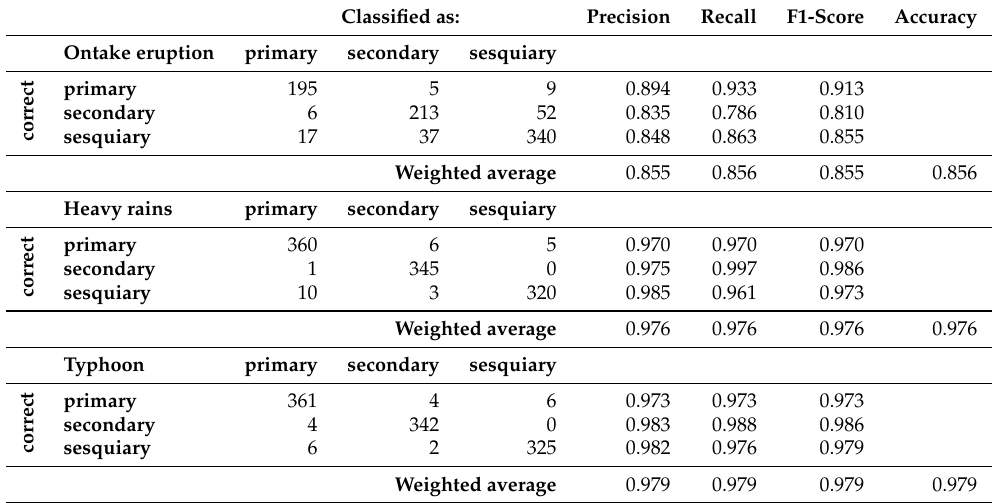
Figure 12. Visualization of classification results for Typhoon tweets. Table 11. Confusion matrices and results of validation on new